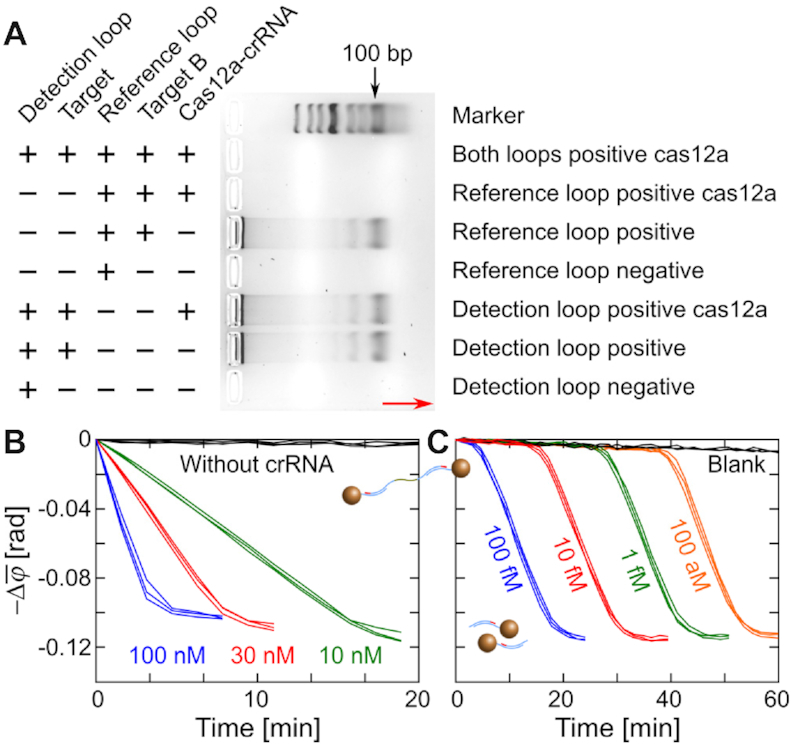
Examination of Cas12a for its capability of nonspecific trans-ssDNA cleavage and compatibility with PG-RCA. (A) Agarose gel electrophoresis analysis for the PG-RCA and CIRI. The red arrow indicates the direction of electrophoresis. (B) Real-time changes of \documentclass[12pt]{minimal}
\usepackage{amsmath}
\usepackage{wasysym}
\usepackage{amsfonts}
\usepackage{amssymb}
\usepackage{amsbsy}
\usepackage{upgreek}
\usepackage{mathrsfs}
\setlength{\oddsidemargin}{-69pt}
\begin{document}
}{}$\bar{\varphi }$\end{document} (1–10 Hz) for disassembly of MNP clusters by Cas12a ternary complexes. Working concentrations of Cas12a are indicated in the plot. (C) Real-time changes of \documentclass[12pt]{minimal}
\usepackage{amsmath}
\usepackage{wasysym}
\usepackage{amsfonts}
\usepackage{amssymb}
\usepackage{amsbsy}
\usepackage{upgreek}
\usepackage{mathrsfs}
\setlength{\oddsidemargin}{-69pt}
\begin{document}
}{}$\bar{\varphi }$\end{document} (1–10 Hz) for disassembly of MNP clusters by PG-RCA activated Cas12a. Target B molecules of different concentrations (indicated in the plot) were added as the primer of RL. Repeated measurements for the same reaction are plotted in the same color.